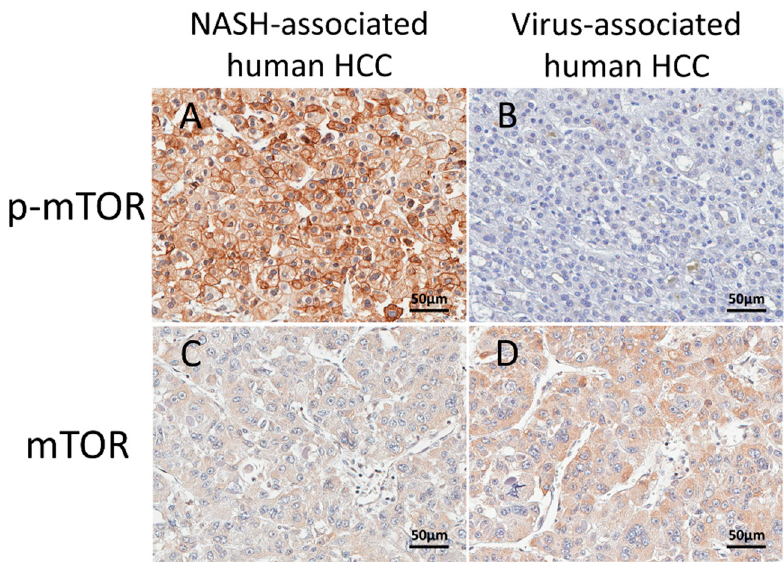
Figure 3. Representative immunohistochemical findings of mTOR and p-mTOR in human metabolic syndrome/NASH-associated and virus-associated HCCs. Immunohistochemistry of p-mTOR in metabolic syndrome/NASH-associated HCC ( A ) and virus-associated HCC ( B ) and mTOR in metabolic syndrome/NASH-associated HCC ( C ) and virus-associated HCC ( D ). Note that p-mTOR was characteristically expressed in metabolic syndrome/NASH-associated HCCs. Scale bar: 50 µ m ( A – D ). HCC: hepatocellular carcinoma.